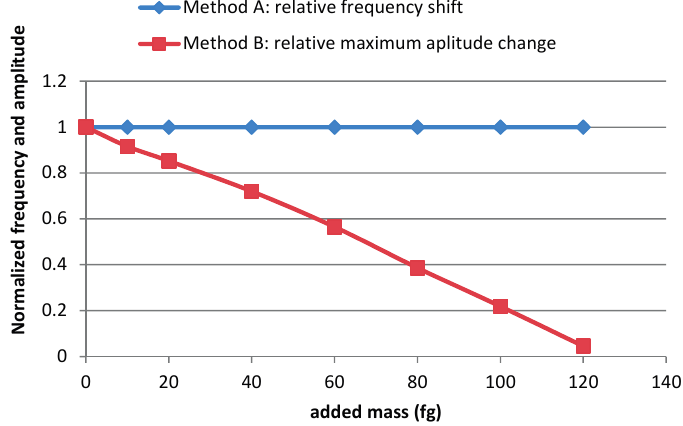
Figure 3. Comparison between the relative change in resonance amplitude and the relative change in resonance frequency versus added